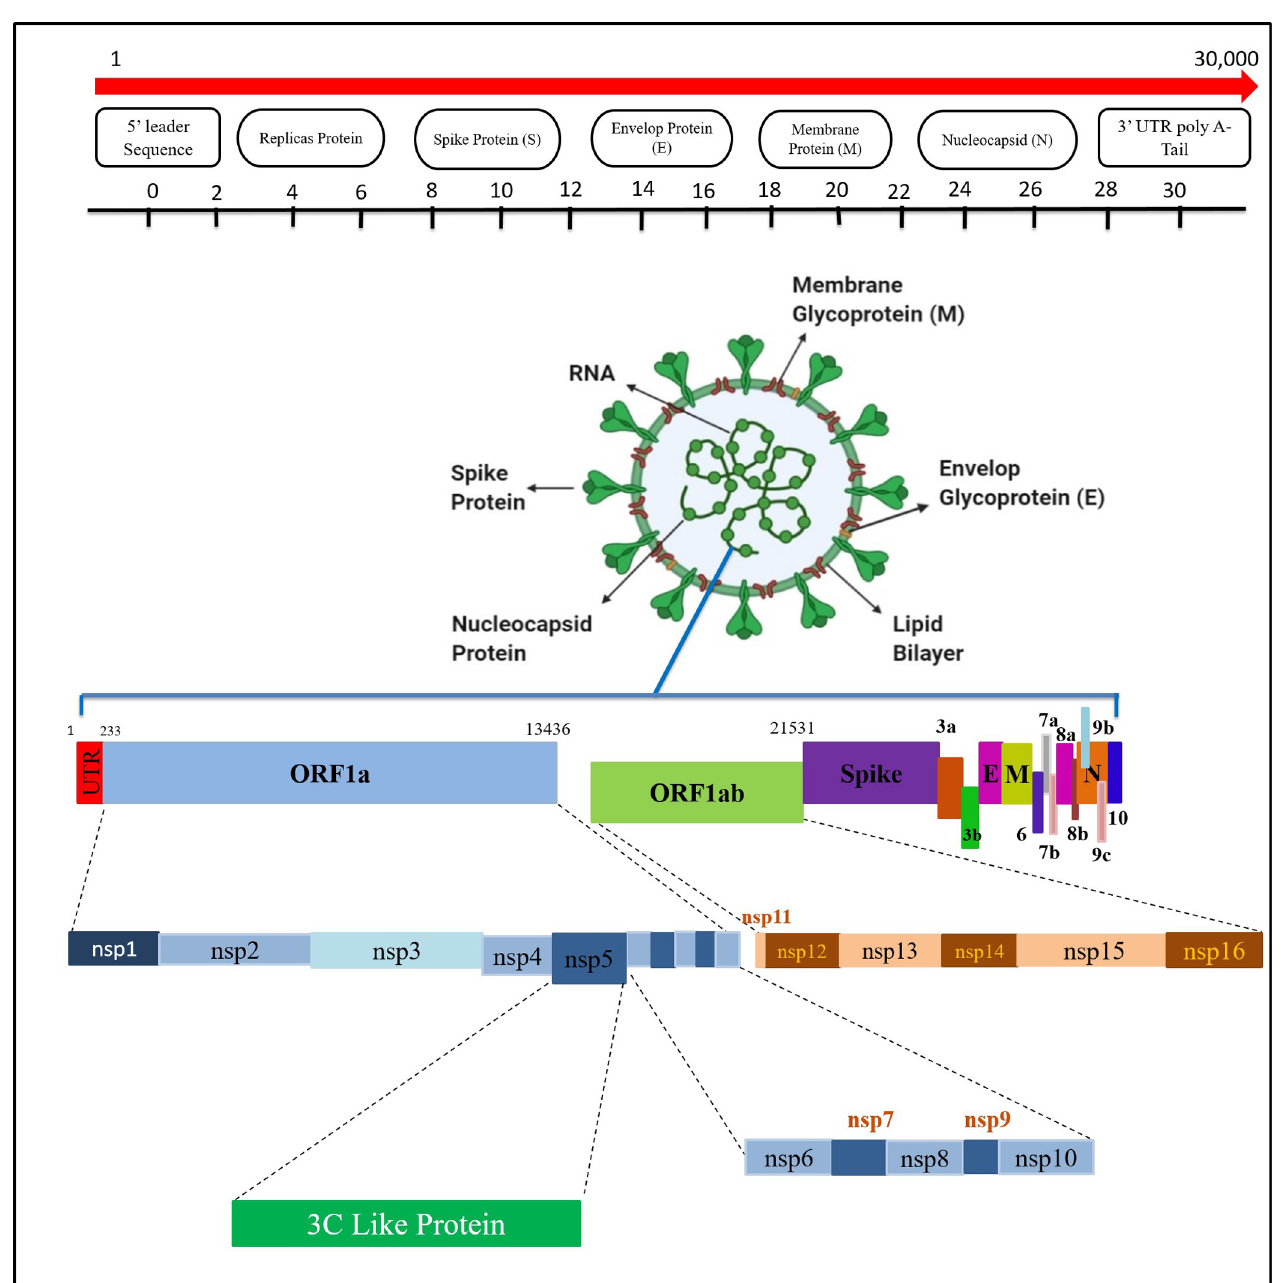
Fig 1. Decoding of coronavirus genome. The CoV genome consists of a 5 00 end, a leading sequence, replicase protein, spikes, envelope, membrane, nucleocapsid, and 3 0 UTR Poly-A-tail end. https://doi.org/10.1371/journal.pone.0264700.g001 axis, and the most likely predicted peptides of SARS-CoV-2 were selected for surface probabil- ity (y-axis) and sequence position (x-axis) analyses. The highest score of the predicted peptides were observed 0.911, ranges from 301 to 306 amino acids with the sequence SGVTFQ, while the lowermost value was observed 0.508, rangs from 1 to 5 amino acids with the sequence SGFRK (S1 Fig).